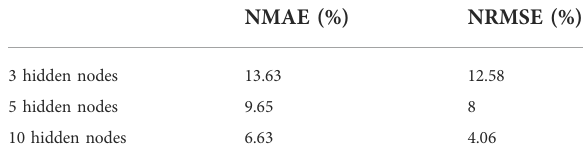
TABLE 4 Evaluation of power demand prediction for 7